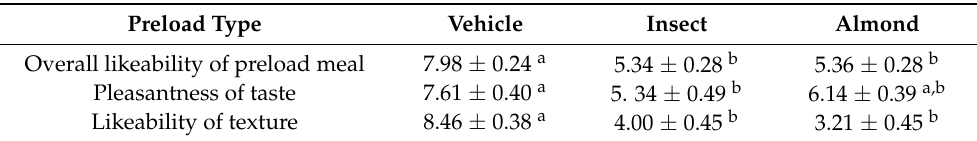
Table 2. Palatability scores (0–10) for the three preloads containing either insect, almond or no protein source (vehicle).